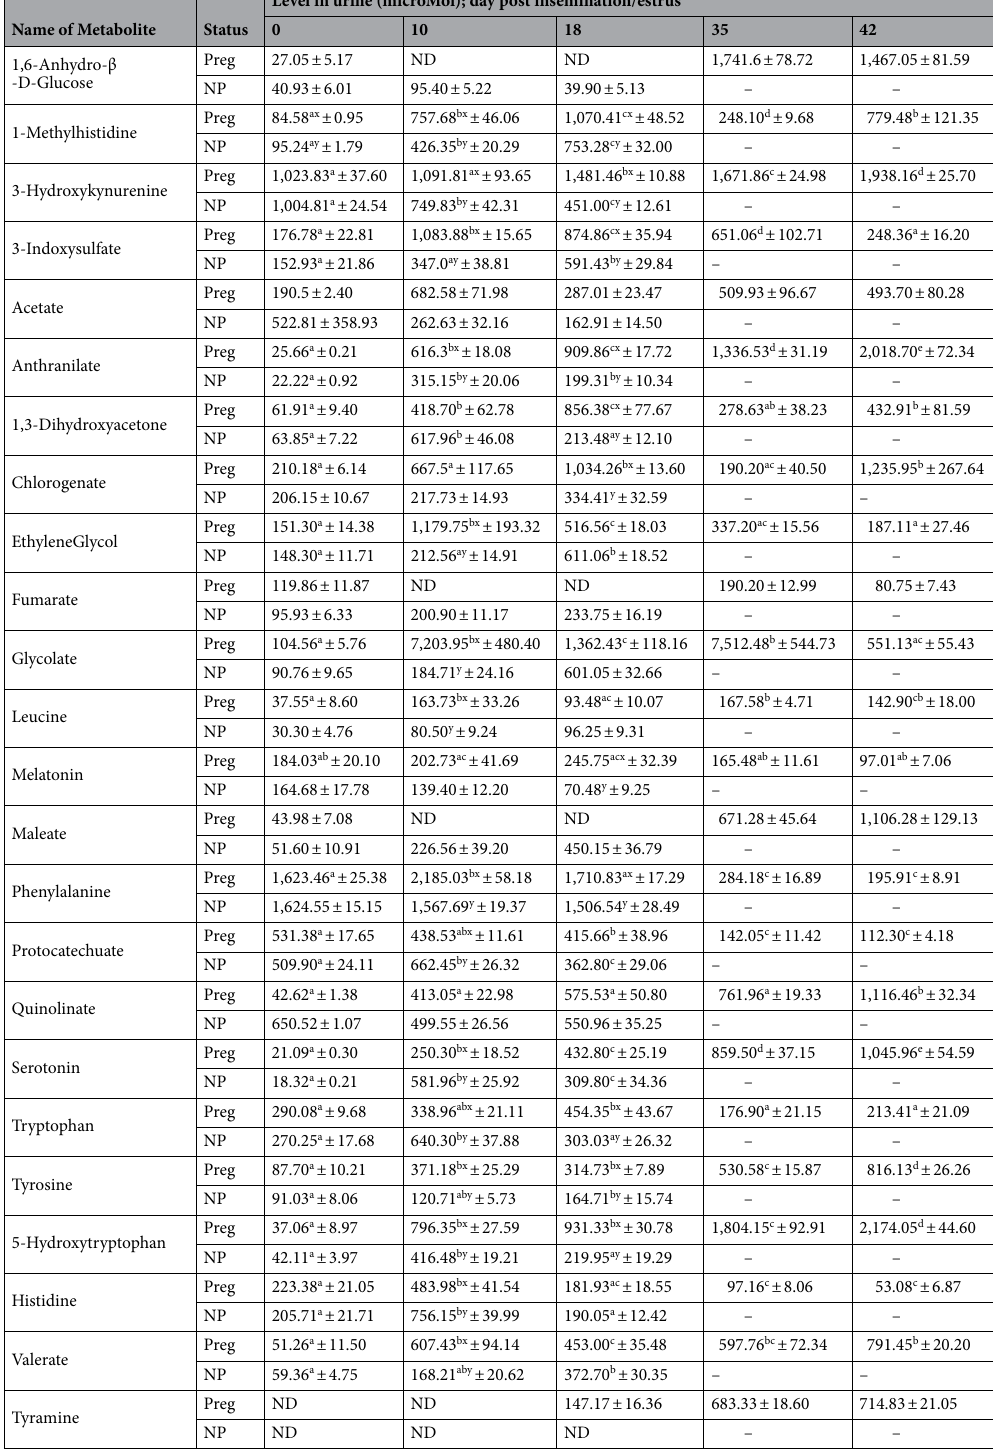
Table 1. Comparative analysis of the urinary metabolites identified and quantified from pregnant and non- pregnant groups of Murrah Buffalo heifers using NMR Spectrometry. Mean with different superscripts (a, b, c and d) within the row i.e. between different days of pregnancy and (x, y) between the row i.e. between pregnant and non-pregnant on same days for a particular group differ significantly ( p < 0.05). Preg. (pregnant), NP (non- pregnant) and ND (not